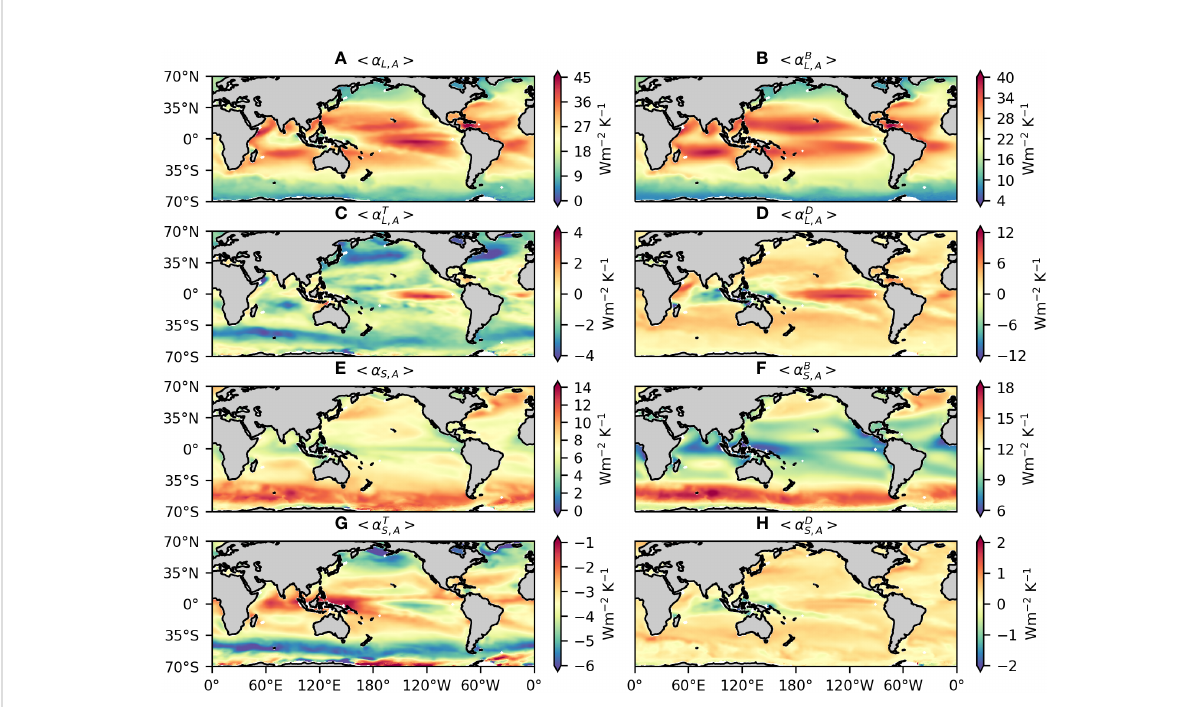
FIGURE 4 Decomposition of < a L > into components related to the (B) background atmospheric and oceanic states < a B L , A > , (C) thermodynamic adjustment < a T L , A > , (D) dynamic adjustment < a D L , A > , and (A) the sum of the above three components < a L , A > . (E – H) Same as panels (A – D) but for < a S > . Note that the colorbars are different for different